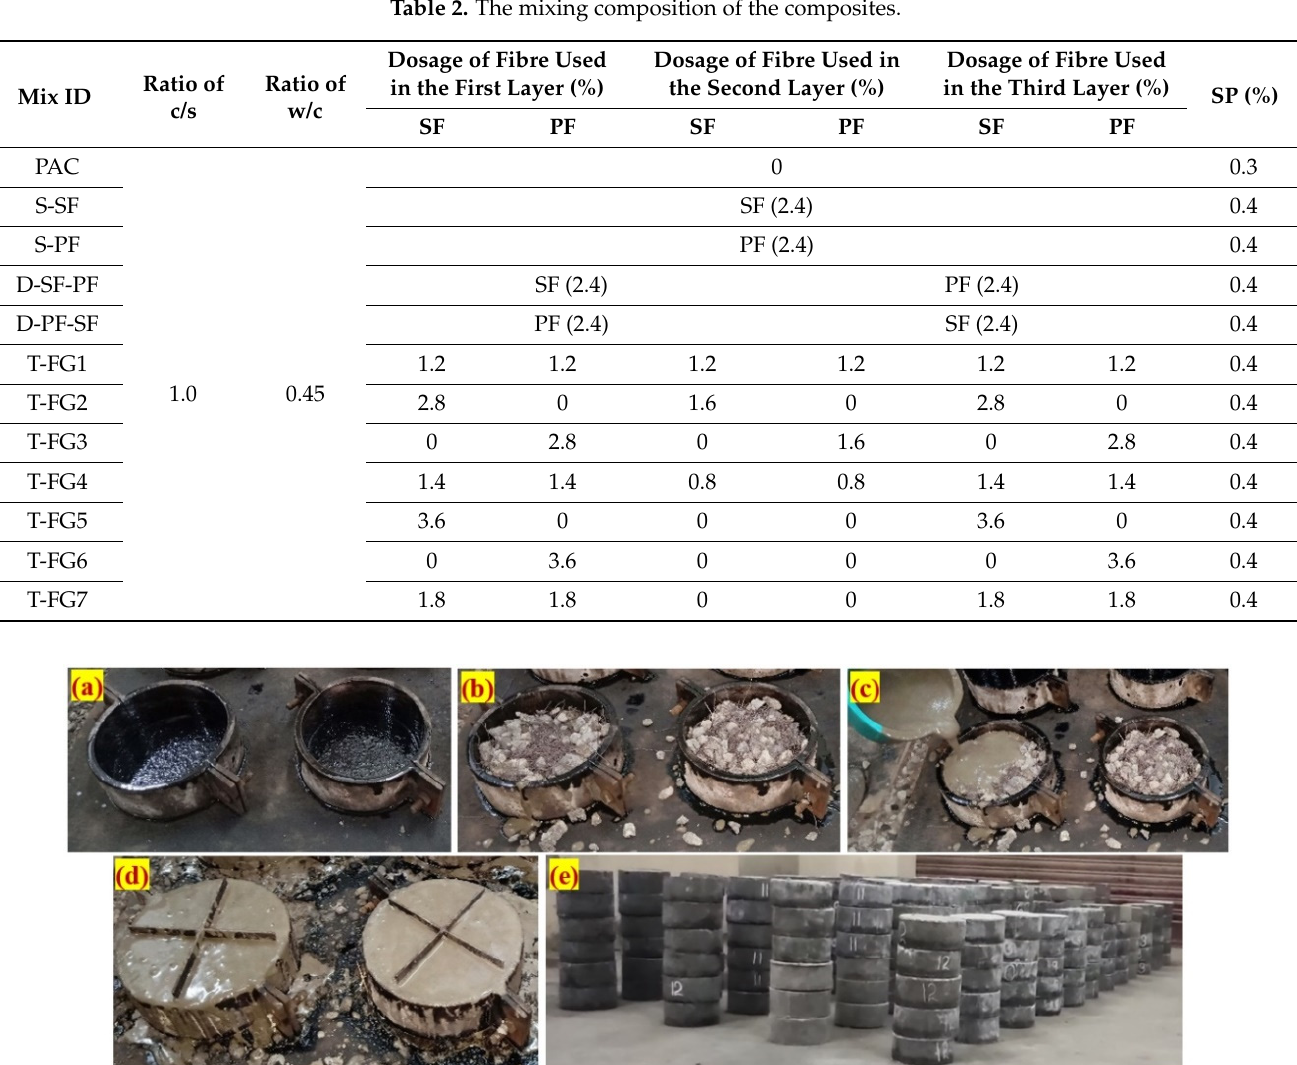
Table 2. The mixing composition of the composites.